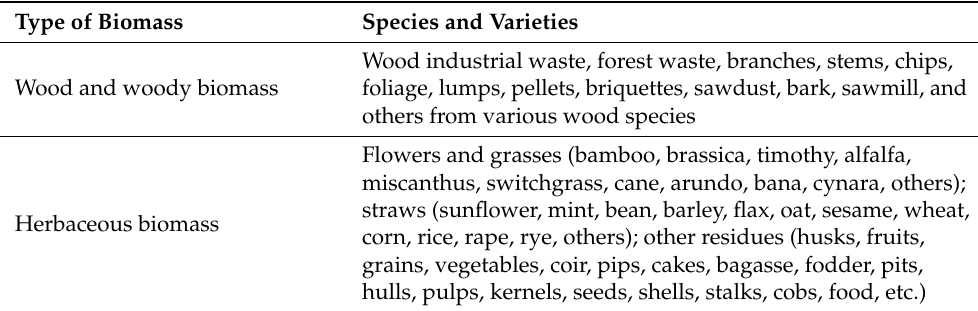
Table 1. Types of biomass and examples